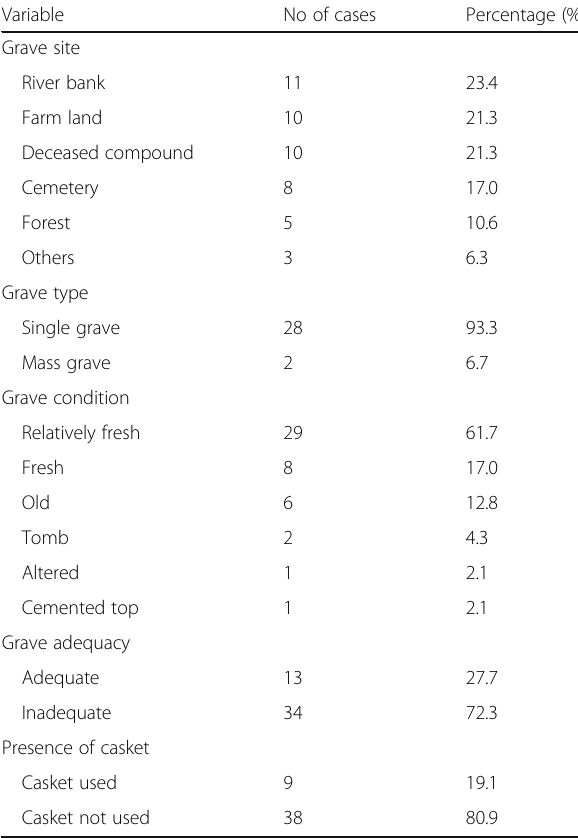
Table 1 Age, sex, history of cases, and venue of autopsies Table 2 Parameters in relation to the